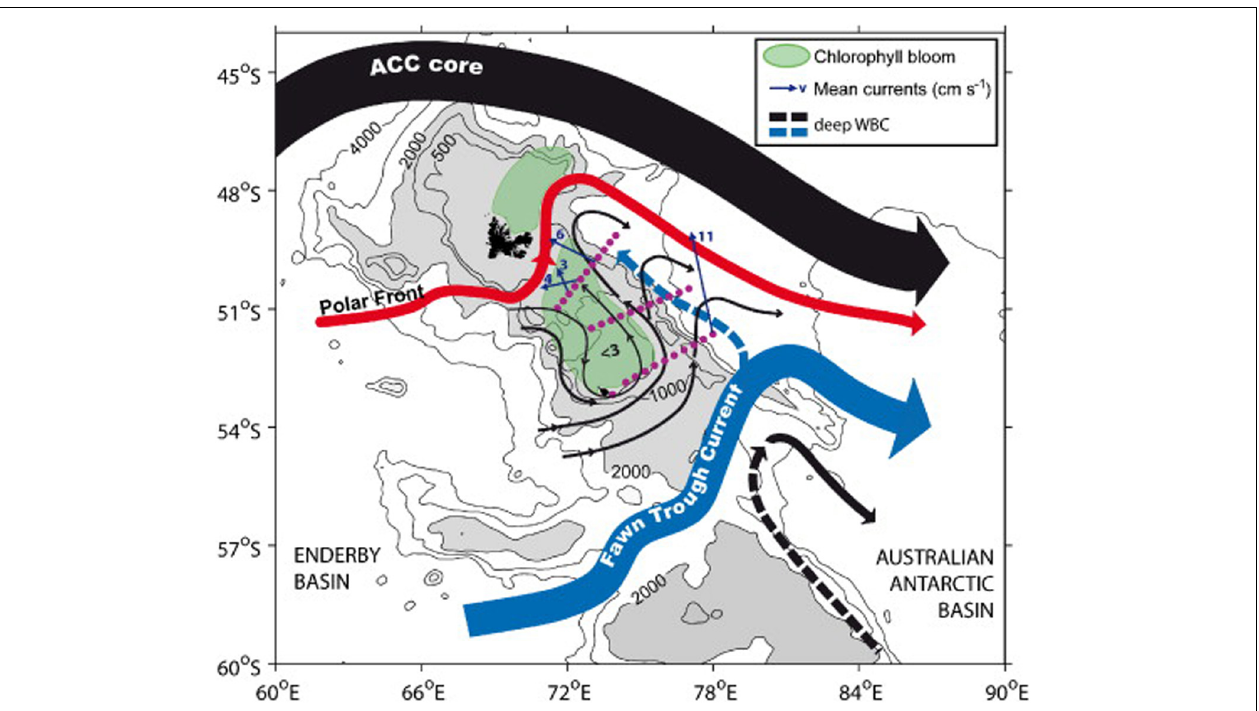
FIGURE 1 | Predominant circulation pattern in the Kerguelen plateau (reproduced with permission from Park et al., 2008b). The green color represents areas where phytoplankton blooms are historically known to develop above the plateau, however high biomass areas also extend eastwards off the plateau in downstream waters. Arrows represent the main circulation patterns above the